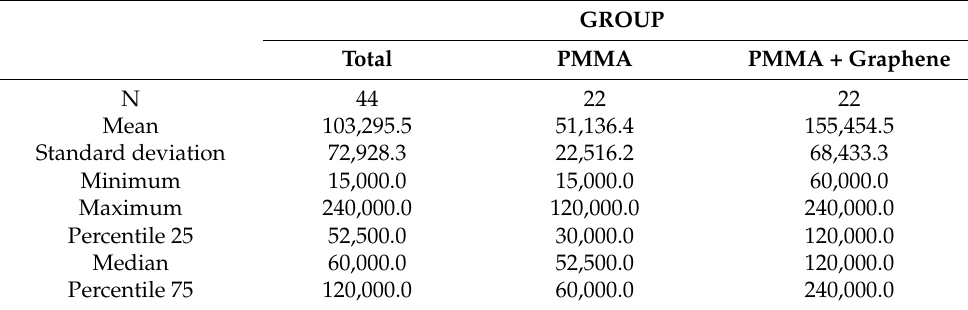
Table 3. Maximum number of loading cycles according to